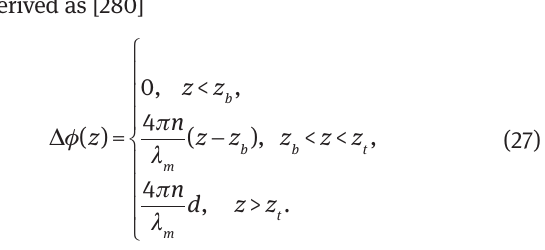
Figure 19: Configuration of a crossed graphene grating that can be used as a polarization converter in reflection. (A) An incident linearly polarized beam with polarization angle α = π /4 impinges normally on a crossed graphene grating, such that the E and E field components interact primarily with the x y bottom and top gratings, respectively. (B) Schematics of the crossed graphene grating. (C) Depending on the value of the phase difference Δ φ , one can engineer reflected optical beams with desired polarization state. Reproduced from Ref. [280].